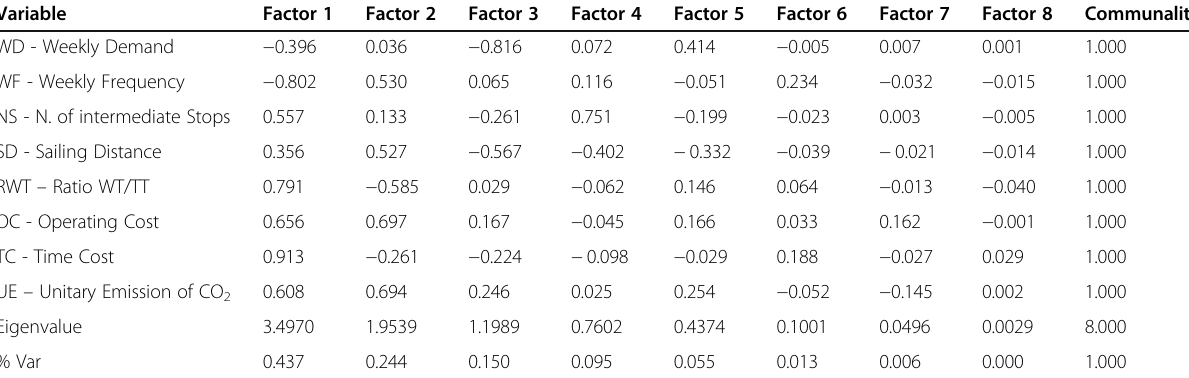
Table 5 Unrotated factor loadings and communalities – Existing network Variable